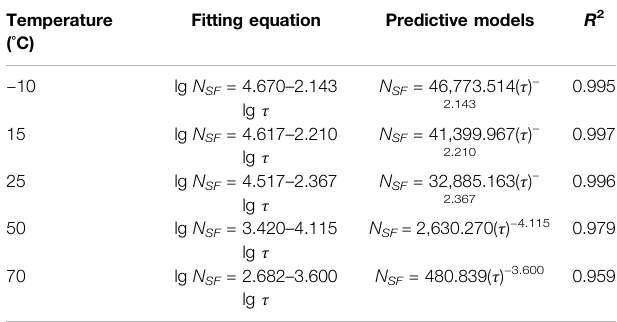
TABLE 5 | Shear fatigue life prediction models for different temperatures. Temperature Fitting equation Predictive models ( ° C)